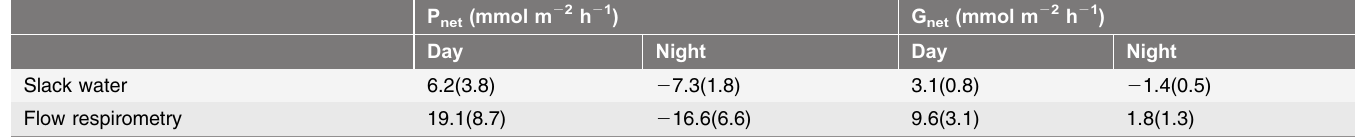
Table 1. Comparison of mean ( ¡ standard error) daytime and nighttime P net and G net values between the two